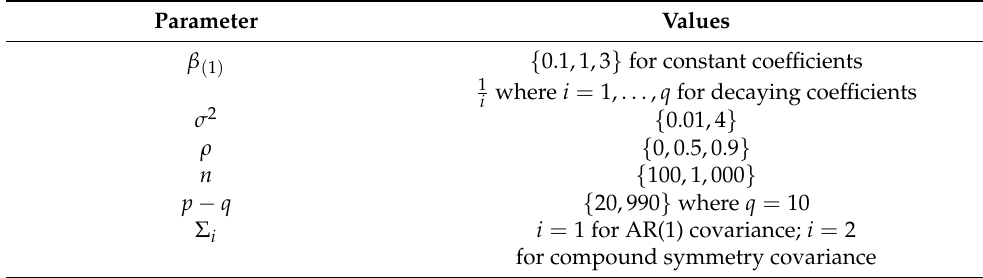
Table 1. Simulation settings for regression estimation and variable